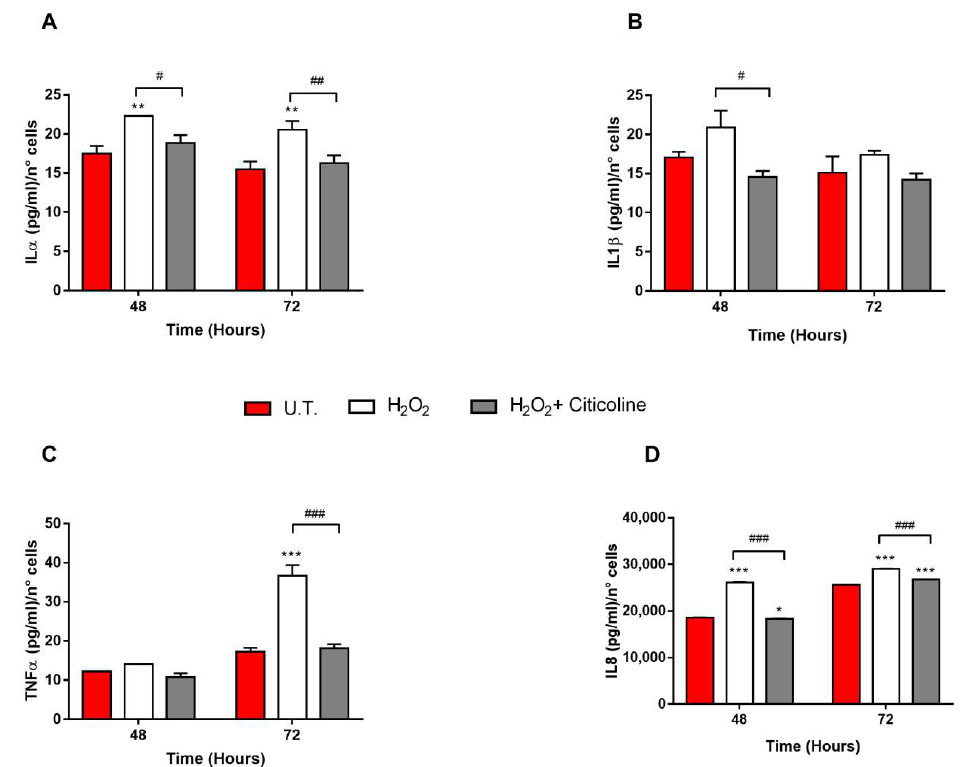
Figure 6. Measurement of pro-inflammatory cytokine release into HTMCs media. The levels of IL1α ( A ), IL1β ( B ), TNFα ( C ) and IL8 ( D ) released by HTMCs in culture media were analyzed by a